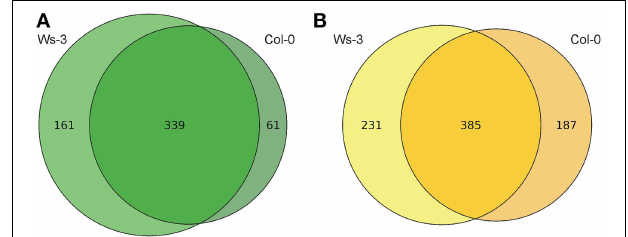
FIGURE 2 | Venn Diagrams of the high quality metabolic features. (A) Features with increased abundance in the leaf samples (Ws-3 vs. Col-0). (B) Features with increased abundance in the inflorescence samples (Ws-3 vs. Col-0).